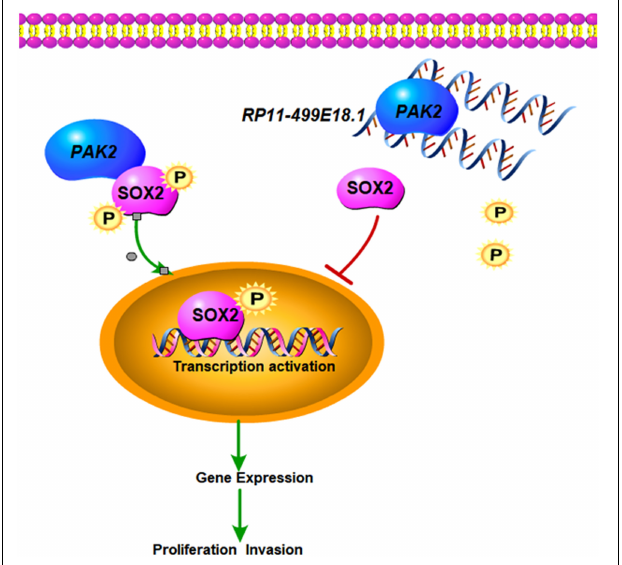
FIGURE 9 | The putative regulation network of this study. Upregulated RP11-499E18.1 inhibits the proliferation, migration, colony formation, and EMT process of OC cells through dissociating the interaction between PAK2 and SOX2 and reducing the nuclear translocation of p-SOX2.